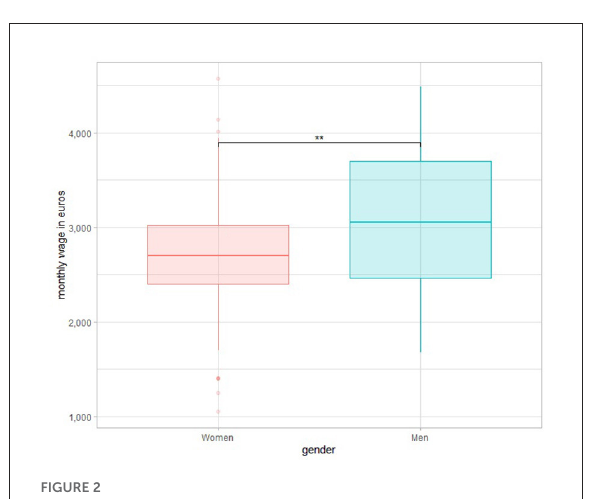
FIGURE2 Wage boxplots according to gender. **P < 0.05.